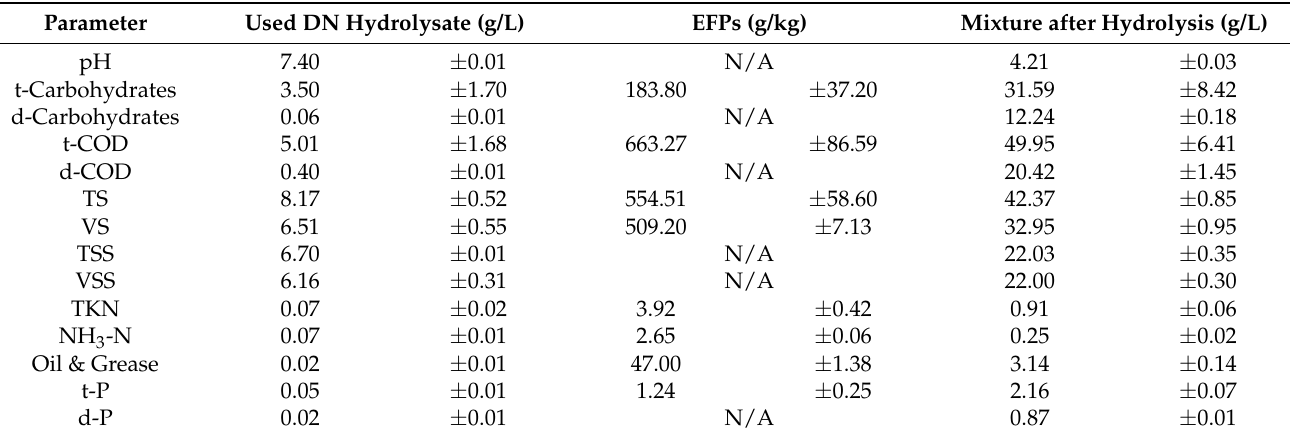
Table 1. Physicochemical characteristics of used DNs hydrolysate, EFPs, and their mixture after hydrolysis (mean value ± standard deviation of three